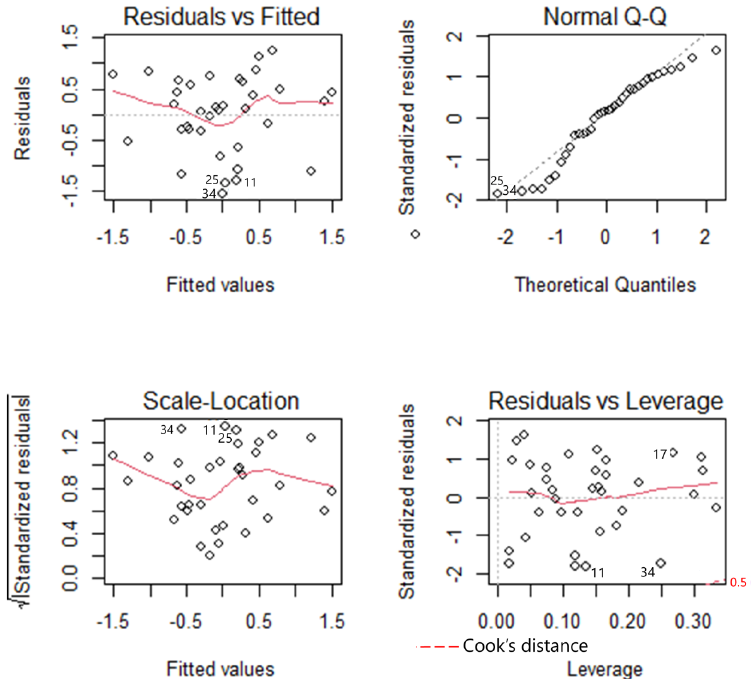
Figure A4. Model diagnostics for the best model with overall spring AA as the explained variable, and 15 climate variables and the Year as explanatory variables for the Lesser Whitethroat Curruca curruca (Table